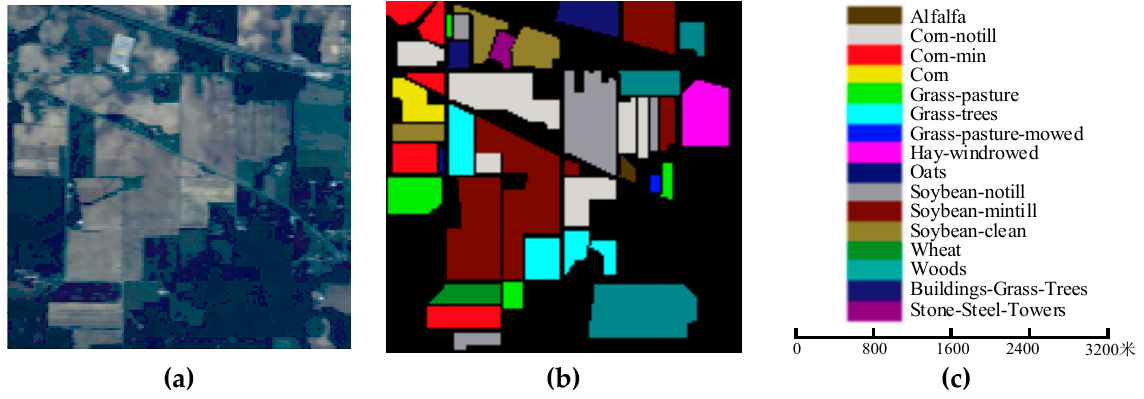
Figure 6. The Indian Pines dataset. ( a ) False-color composite image; ( b ) ground truth map; ( c ) scale bar. Each dataset is divided into three subsets: training set, validate set, and test set. The training set consists of 200 labeled samples for model training, which are randomly selected from all the labeled samples, the validate set includes 50 labeled samples for guiding the model, and the remains are used as the test